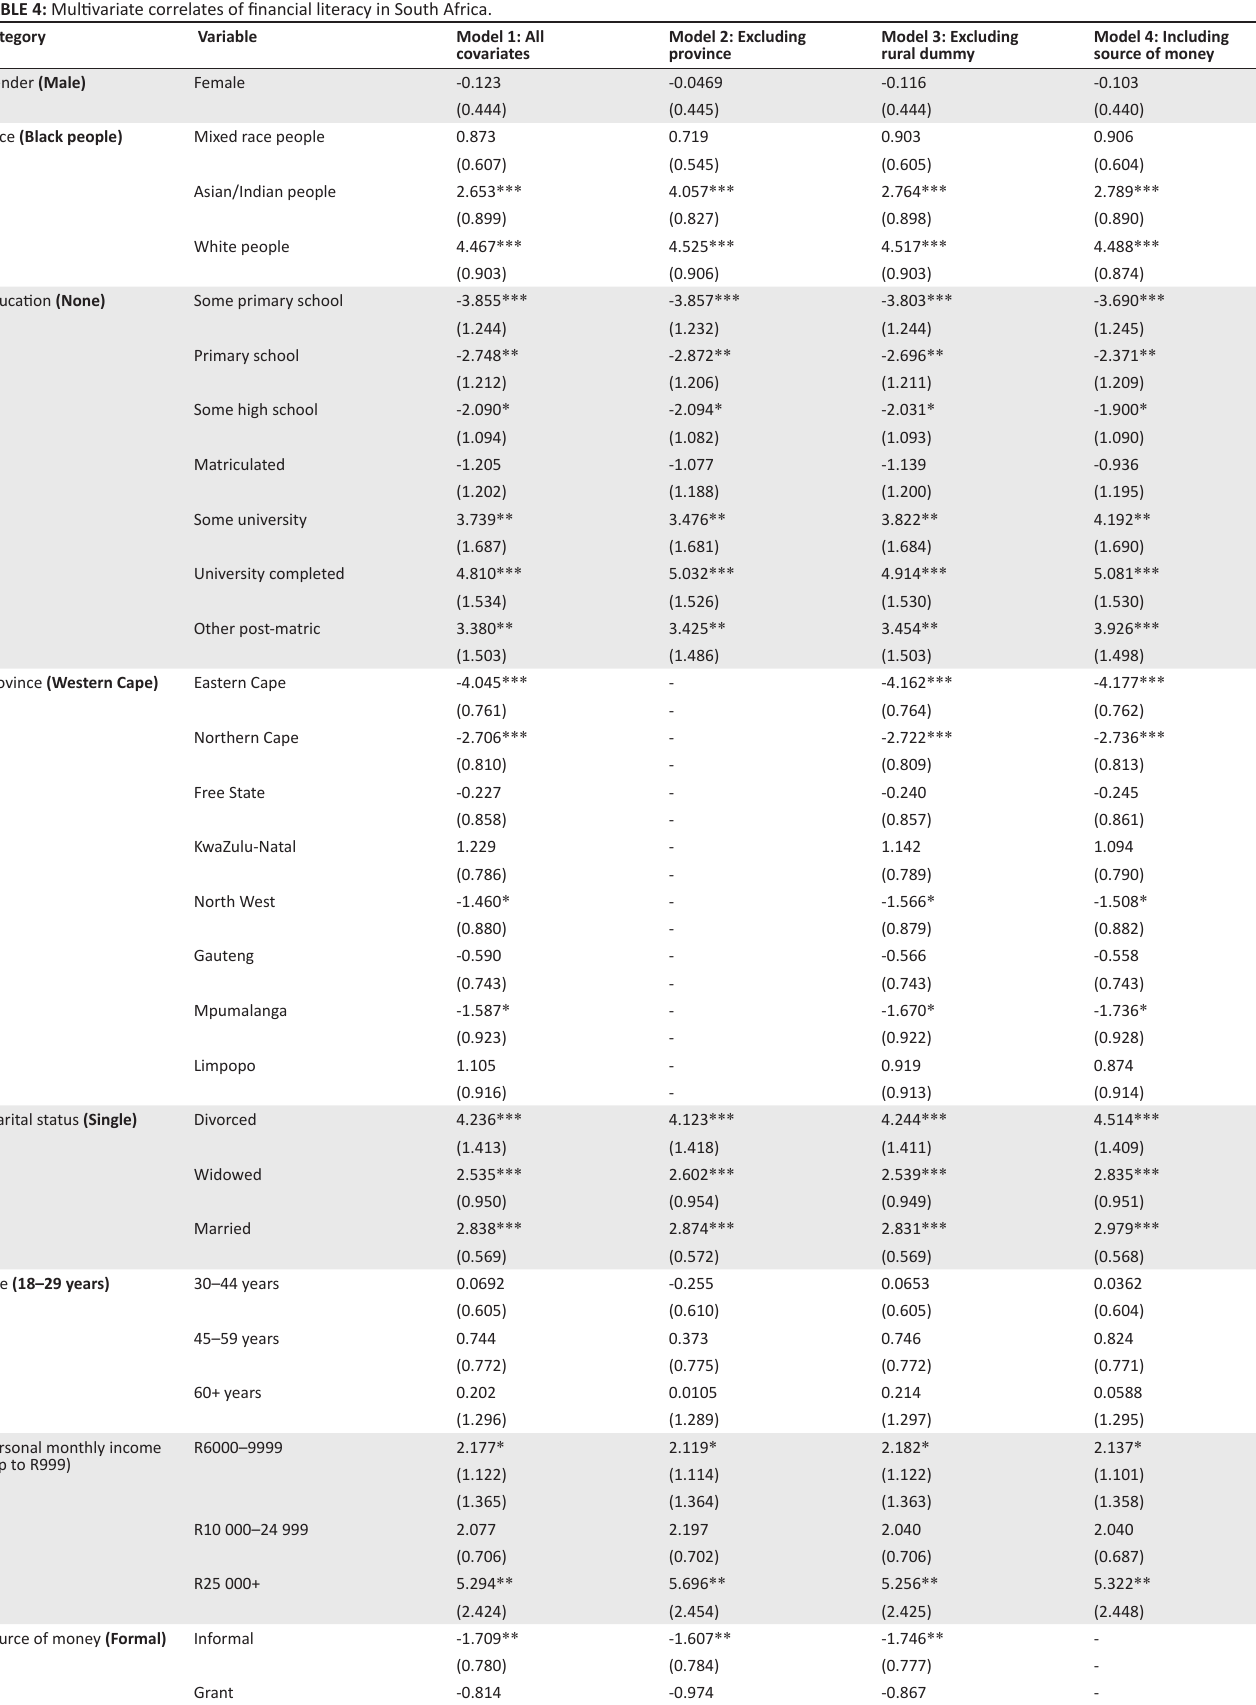
TABLE 4: Multivariate correlates of financial literacy in South Africa.